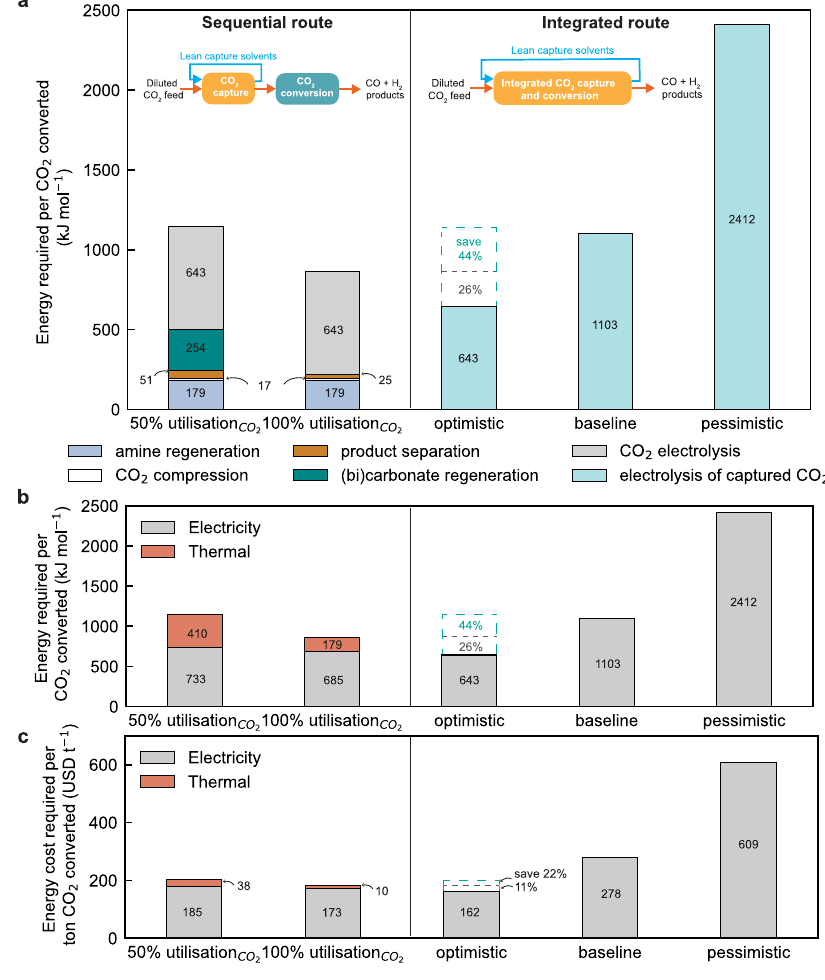
gas-fed electrolysers that show 50% CO 2 utilisation or future scenarios with 100%